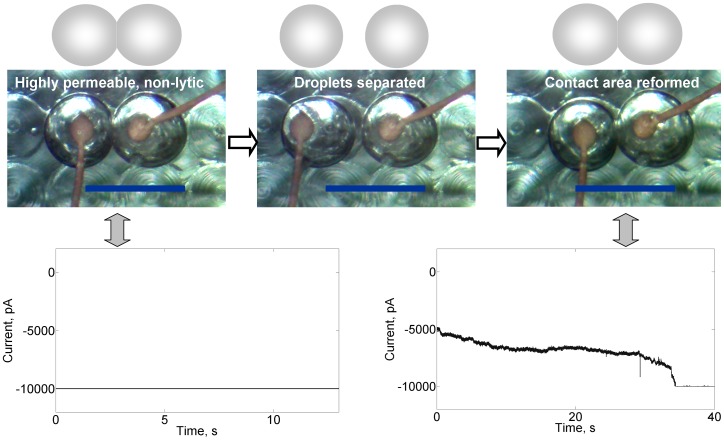
Reversibility of the highly permeable non-lytic membrane state which occurs at high cyt c concentrations.Microscopy and cartoon images are shown in the top panels; for clarity, the cartoons show the droplet configurations seen in the images. Current (bottom panels) across the intact bilayer can be halted by physically separating the droplets. Current is reestablished (to the overloading level) when the droplets are brought back together to reform the permeable bilayer. Buffer: 200 mM KCl, 10 mM MOPS, pH 7.4; membrane composition: DPhPC/chol/CL  = 60%/25%/15%; cyt c: 25.4 µM; voltage clamp: −50 mV.